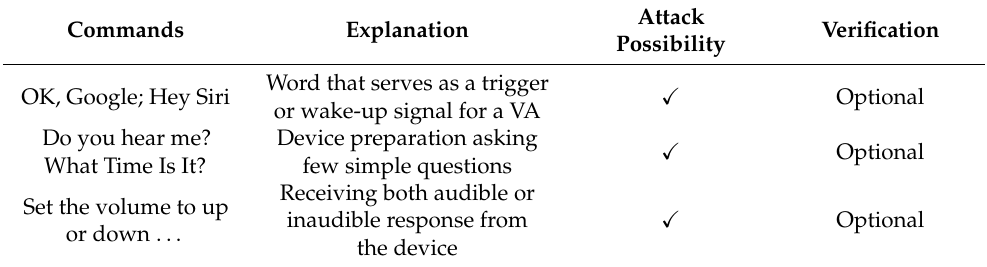
Table 2. Voice commands setup.